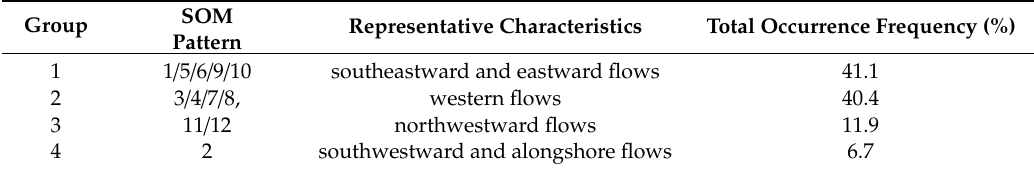
Table 1. Categories of SOM patterns for model results.